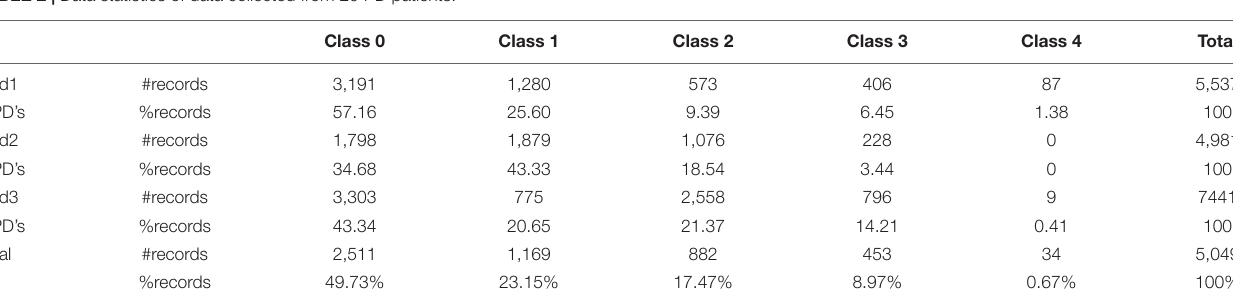
FIGURE 6 | An illustration of threefold cross validation in order to avoid overfitting results. Gray box refers to testing data, where the remaining white boxes are training data. TABLE 2 | Data statistics of data collected from 20 PD